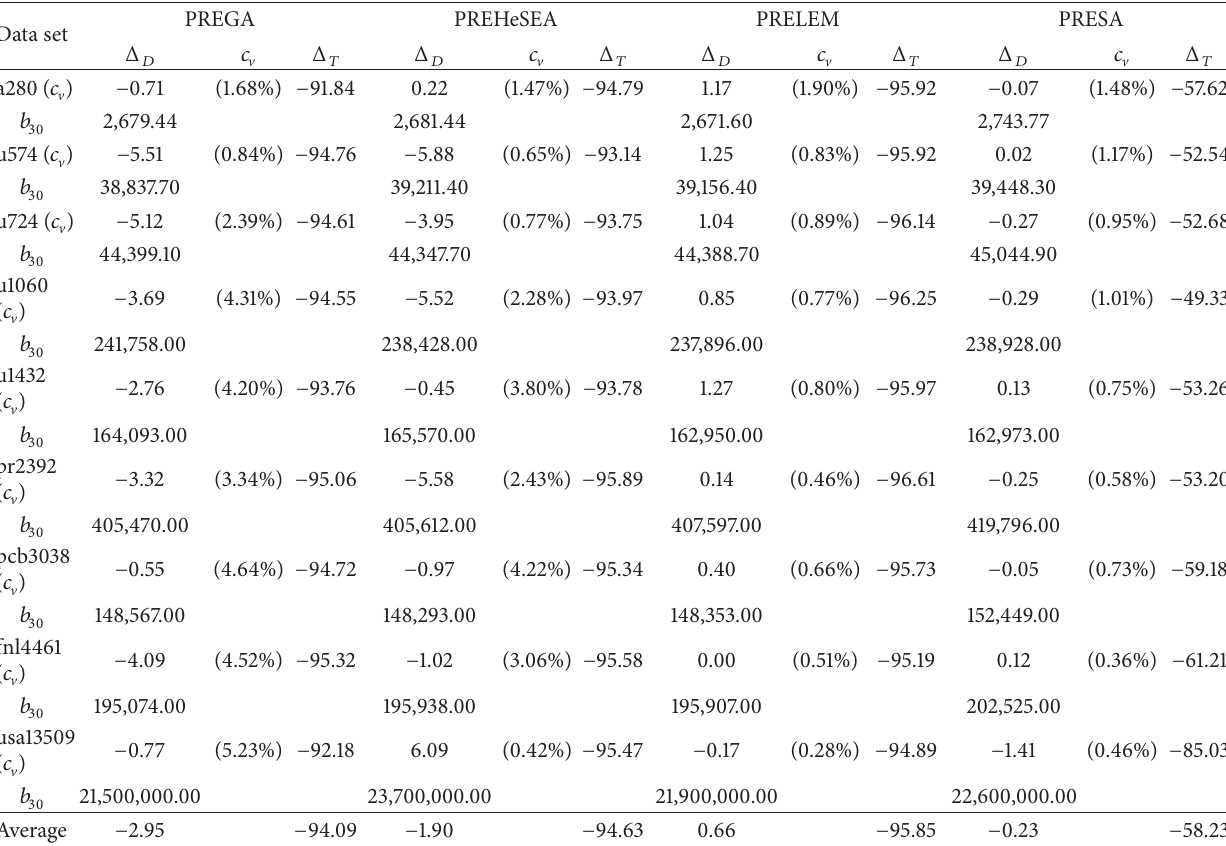
Table 3: Simulation results of GA, HeSEA, LEM, and